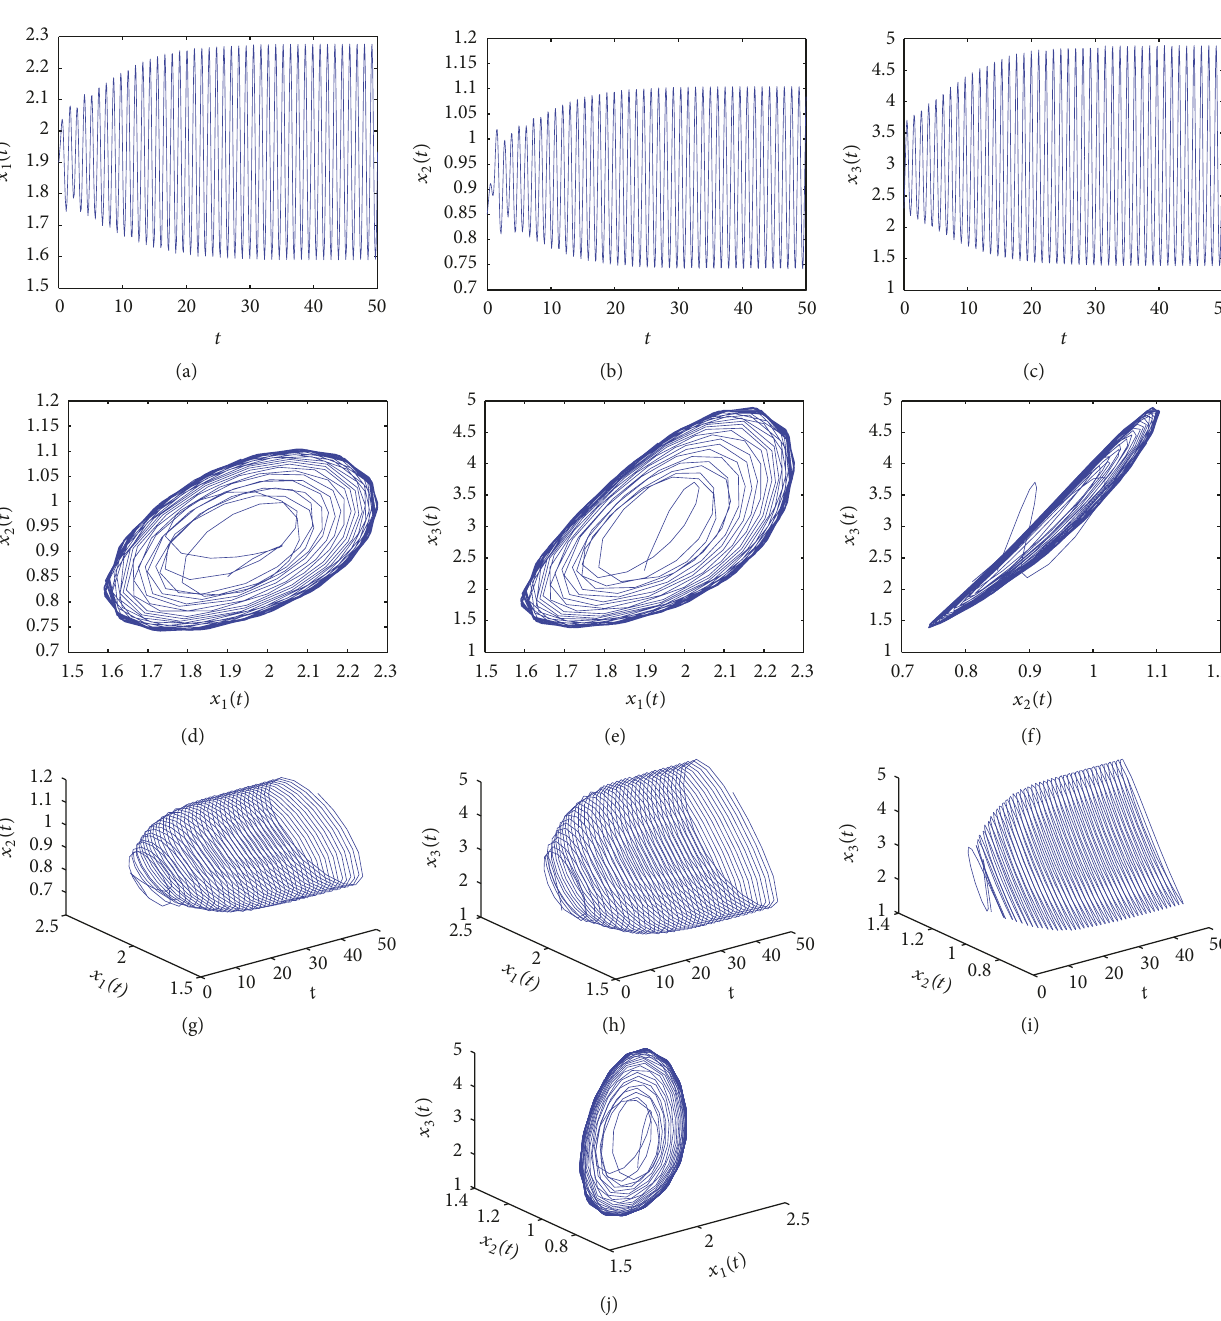
(0), 𝑥 (0),𝑥 (0)) = (1.9, 0.85, 2.3) . 1 2 3